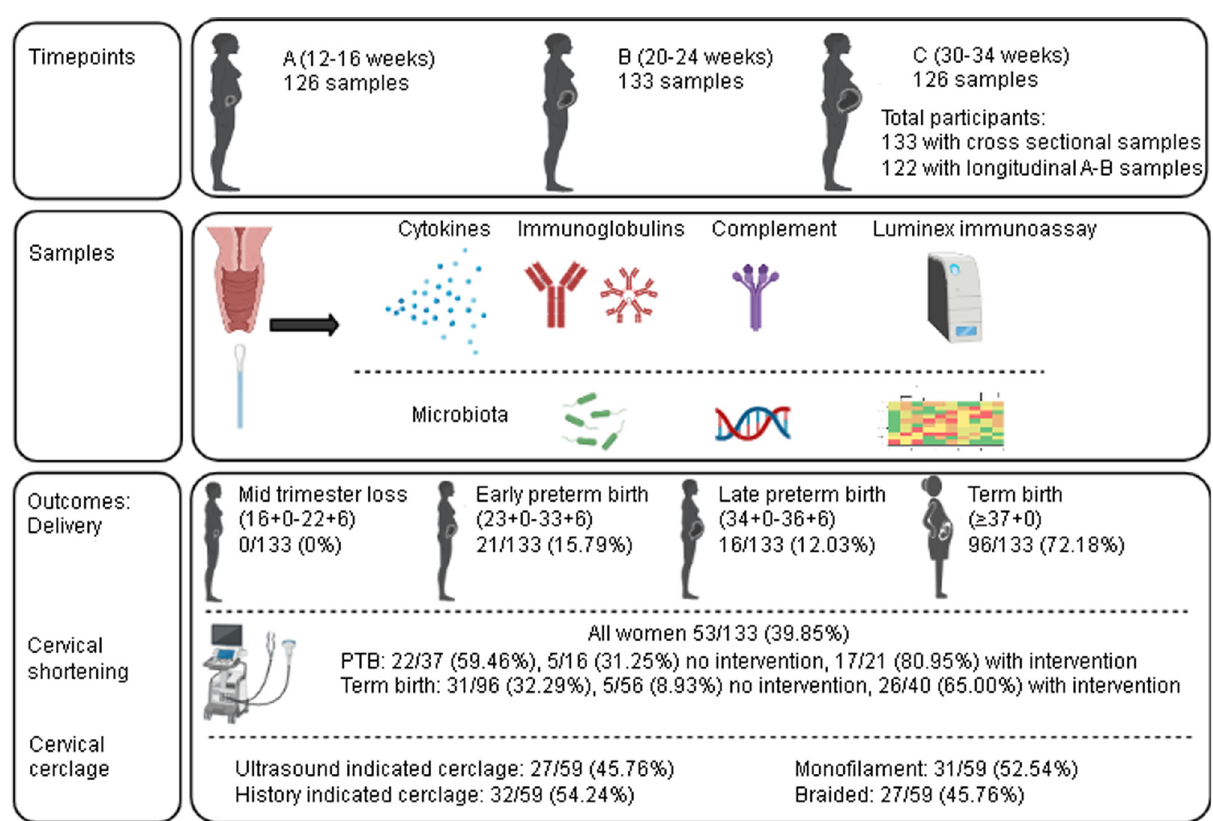
Fig. 1 Study design. Women at high risk of preterm birth due to the presence of risk factors were recruited from preterm birth prevention clinics where cervical length ultrasound scans were performed, and cervical cerclage was placed where indicated. Cervicovaginal samples were taken at three timepoints: A (12 – 16 weeks), B (20 – 24 weeks) and C (30 – 34 weeks). Cervicovaginal fl uid was analysed for mediators of in fl ammation (IL-8, IL-6, IL-1 β , IL-10, TNF- α , IFN- γ , GM-CSF, IL-5, IL-4, IL-2, IL-18), complement proteins (C3b, C5 and C5a) and mediators of microbial recognition (MBL, IgM, IgG1-4, and IgA). Bacterial DNA was extracted and microbial composition was determined by next generation sequencing. The spontaneous preterm birth rate was 27.82%< 37 weeks and 15.79%< 34 weeks. Of the whole study population, 39.85% of women were identi fi ed with cervical shortening (de fi ned as a cervical l length of ≤ 25 mm), compared to 59.46% of women who delivered preterm and 8.93% of women who delivered at term without intervention. Of the cerclages placed, 45.76% were placed due to a short cervix (ultrasound indicated) and 54.24% were placed prior on the basis of clinical history (history indicated). Mono fi lament was used in 52.54% and braided suture material was used in 45.76% of cases. There was one case where cerclage material type was not known. Figure created with